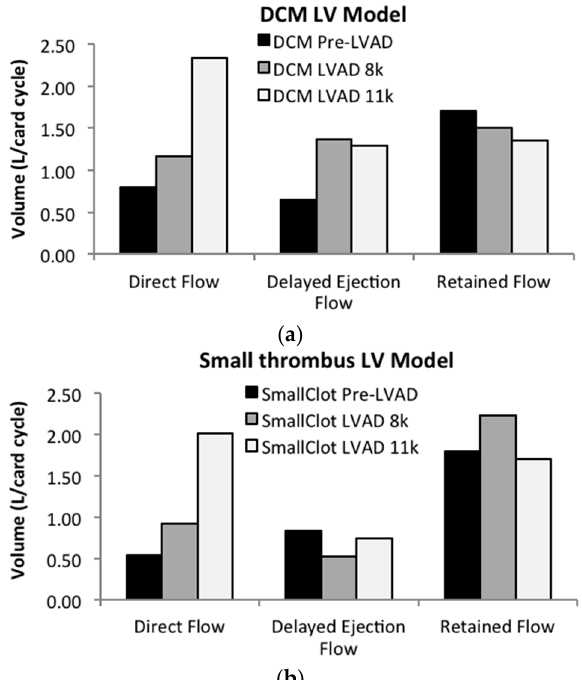
Figure 7. Distribution of flow calculated for each condition. Direct flow is blood ejected during the first cardiac cycle, Delayed Ejection Flow is ejected during the second cycle, and the Retained Flow is blood with residence time longer than two cardiac cycles. The flow fractions are calculated from the particle analysis and scaled by the total aortic flow measured from the experimental studies. ( a ) DCM LV Model; ( b ) Small thrombus LV Model.